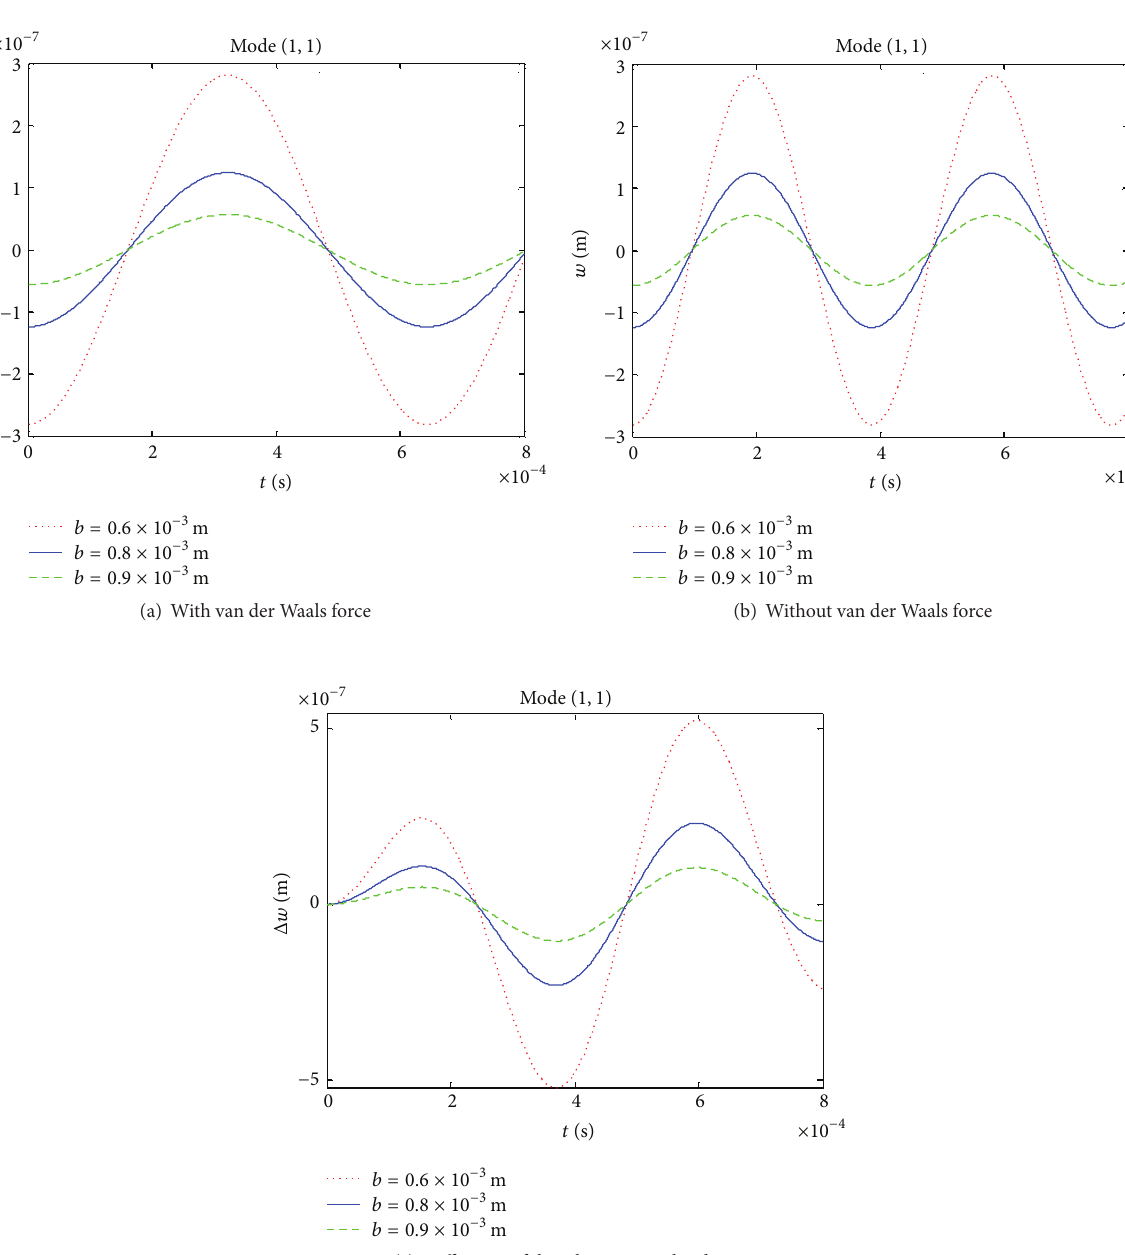
is considered. As the length 𝑎 of the micro film grows, the effects of the van der Waals force on the vibrating amplitudes of the film center become large.